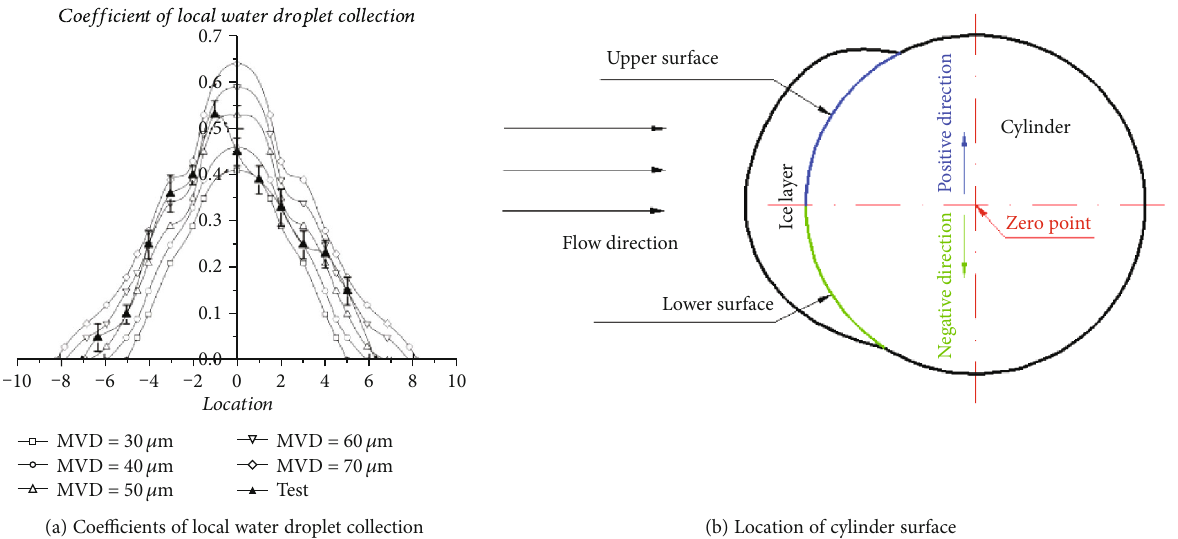
Figure 12: Comparison of the coe ffi cient of local water droplet collection between test and calculation. Table 2: Values of the system parameters. Item Value Experimental temperature -15 ° C Flow